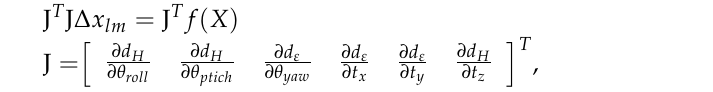
current frame point cloud p t in XYZ coordinate system and the corresponding point p M in i X M Y M Z M coordinate system can be obtained, as shown in Equation